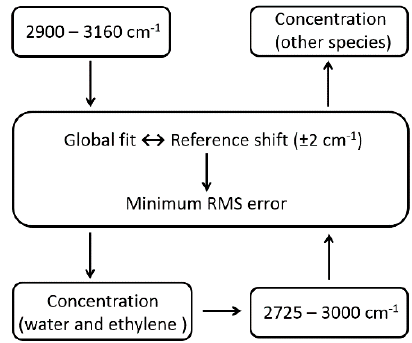
Figure 5. Procedure overview of a two-stage global fitting method for concentration calculation.